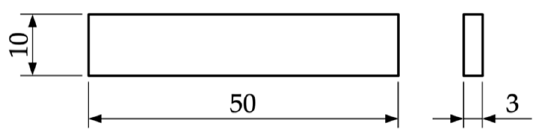
Figure 5. Bending specimen with length 50 mm, width 10 mm and height 3 mm. The specimens were printed horizontally so that the height correlated with the stacking direction.